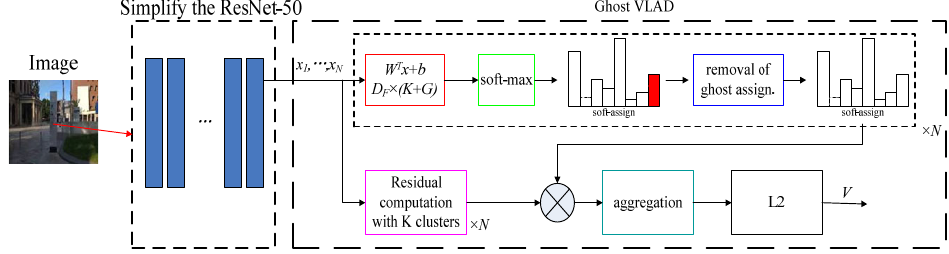
Figure 4. Network structure of ResNet based on GhostVLAD.